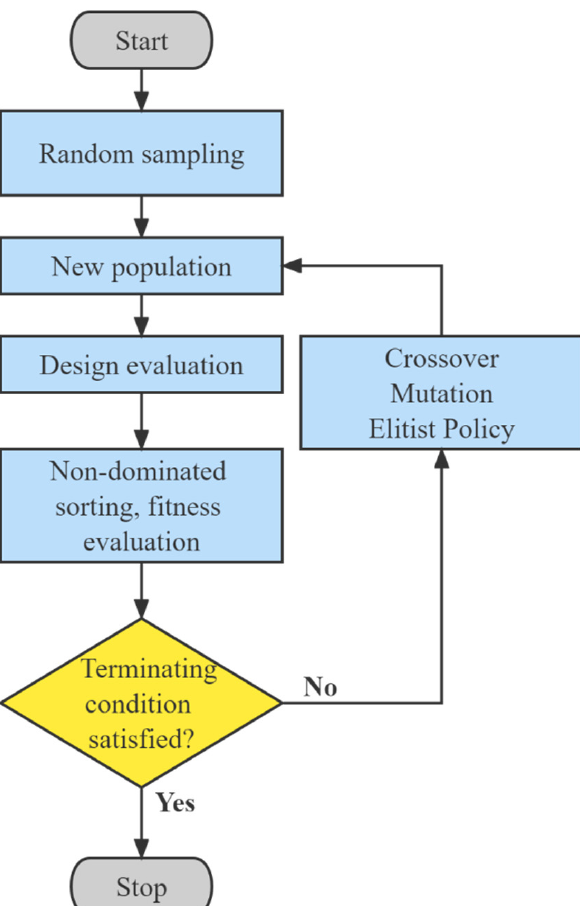
Figure 23. The flow of the MOGA